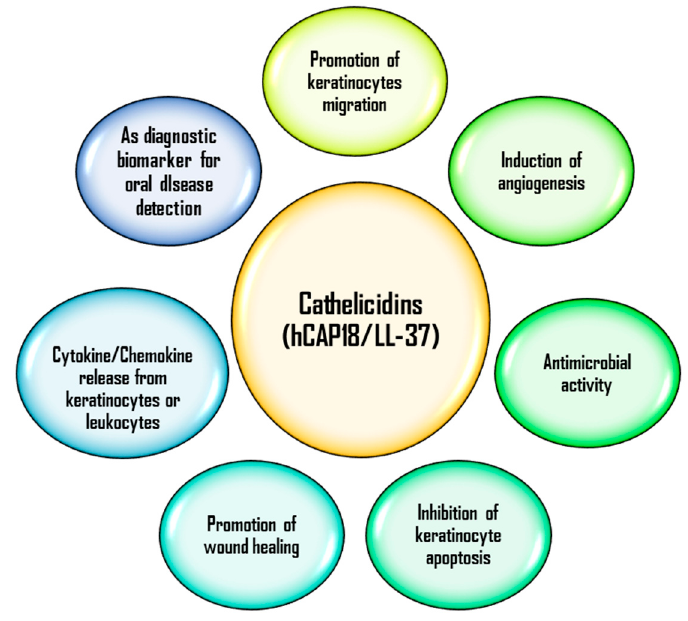
Figure 1. Different functions of human cathelicidins (LL-37) peptides in the human body [4]. hCAP18: human cationic antimicrobial peptide 18 precursor protein.